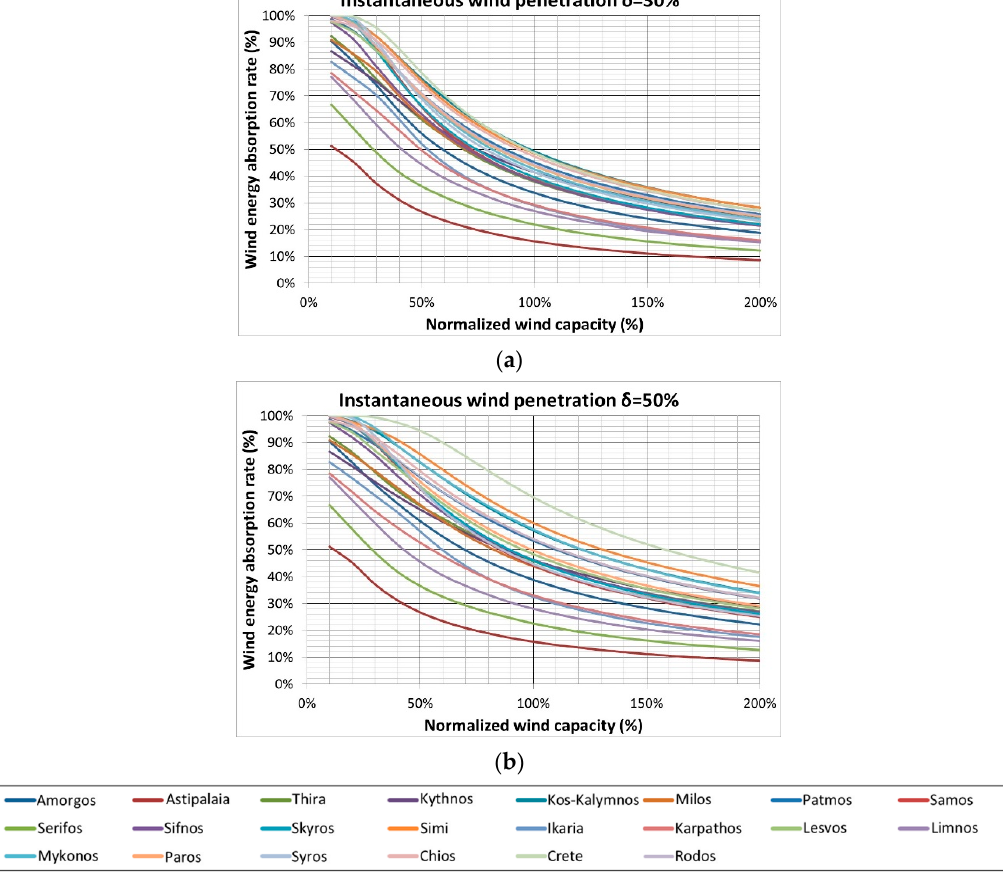
Figure 15. Wind energy absorption rate for different instantaneous wind penetration δ : ( a ) 30%, ( b ) 50% (without PV capacity).